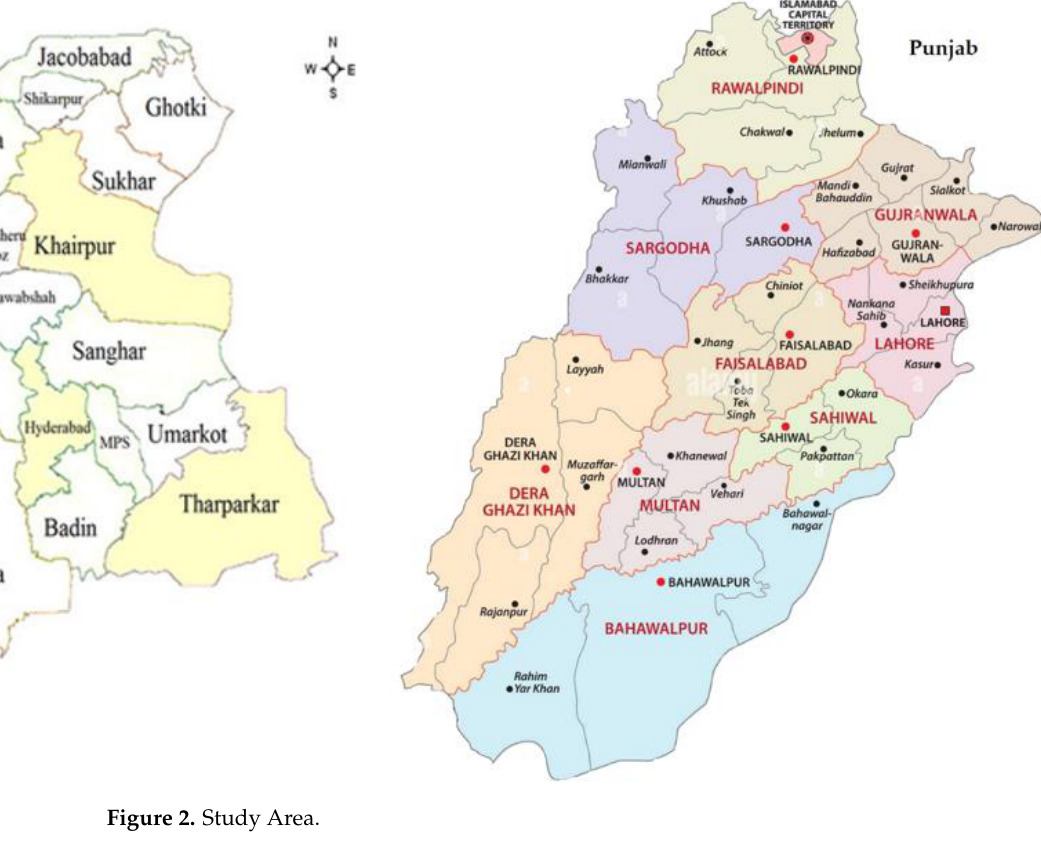
Figure 2. Study Area.